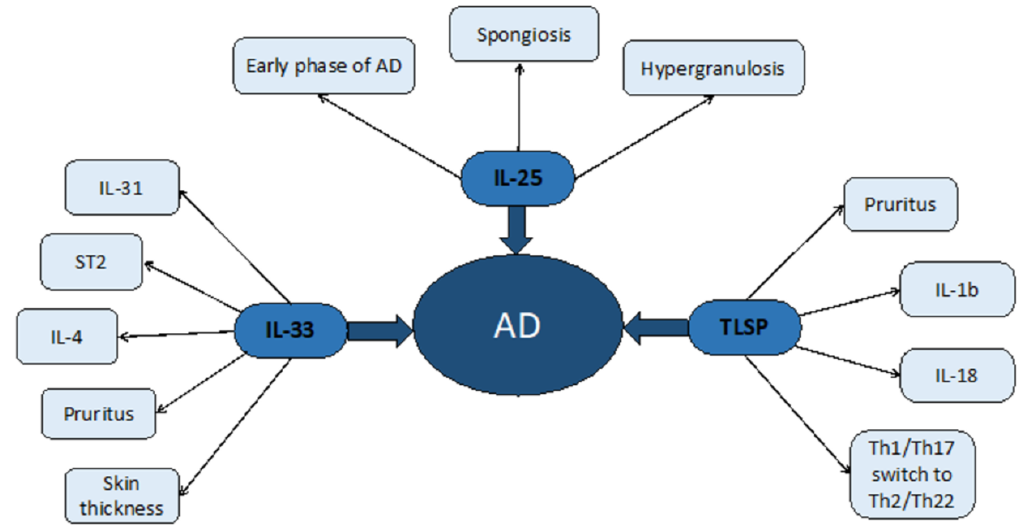
Figure 2. Atopic dermatitis, as in the previous image, has been represented in the middle with the three cytokines examined depicted around it. Secondary effects and symptoms consequent to epithelial cytokines have been represented on the side of the picture.